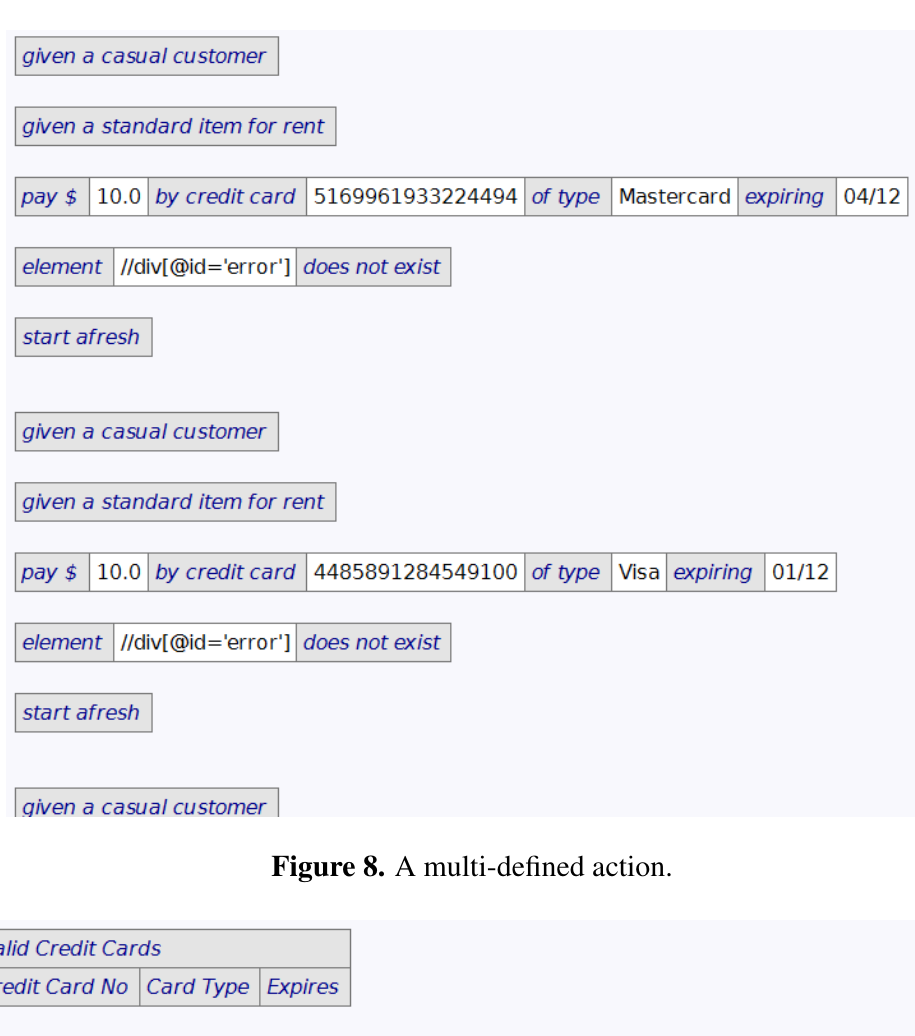
Figure 7. A repeating test.